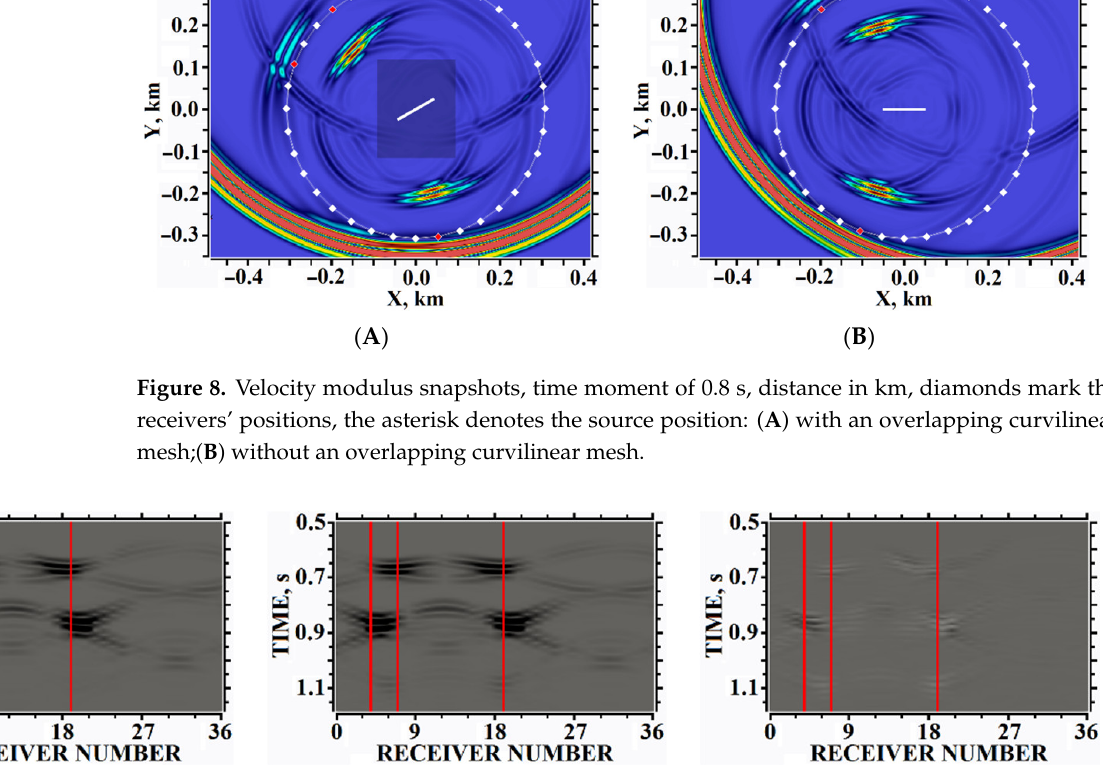
Figure 9. Seismograms, anomalous velocity modulus: ( A ) with an overlapping curvilinear mesh; ( B ) without an overlapping curvilinear mesh; ( C ) difference.